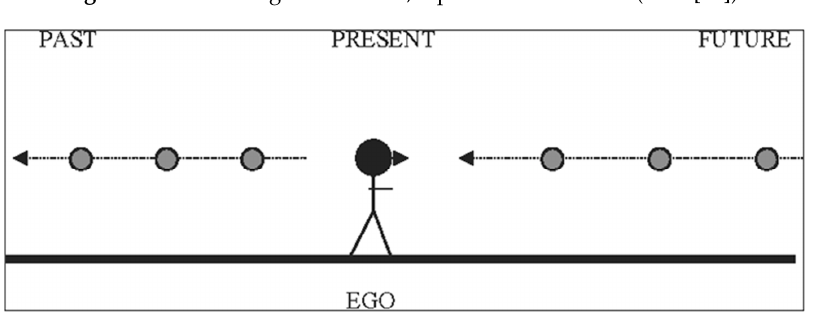
Figure 6. The Moving Ego Model; reprinted from Evans (2007 [20]).